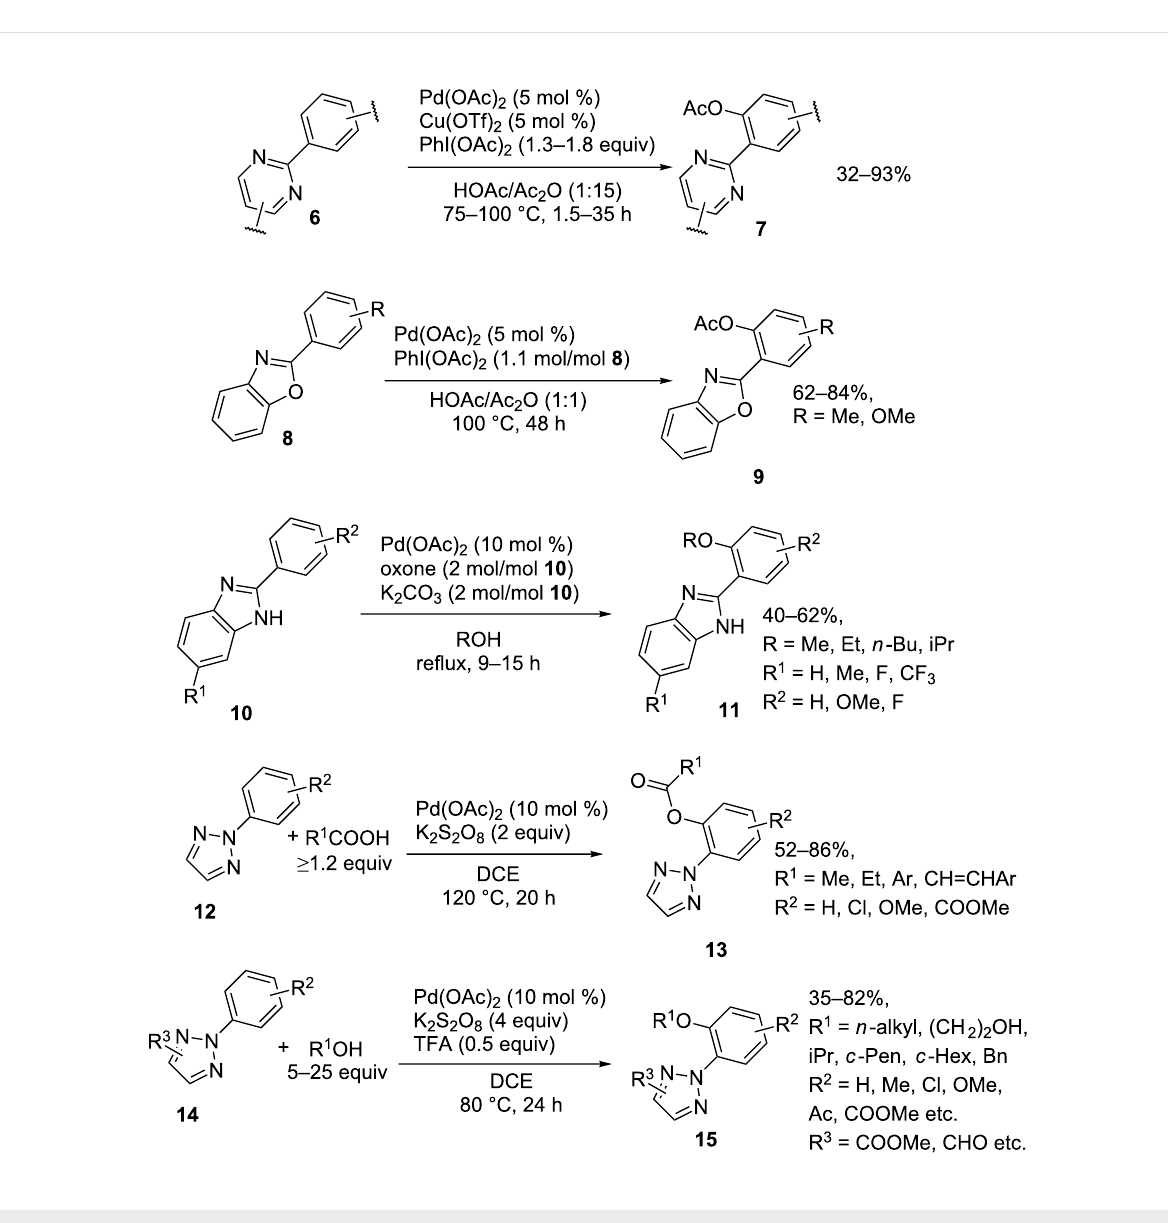
Scheme 4: ortho- Acyloxylation and alkoxylation of arenes directed by pyrimidine, benzoxazole, benzimidazole and triazole groups.